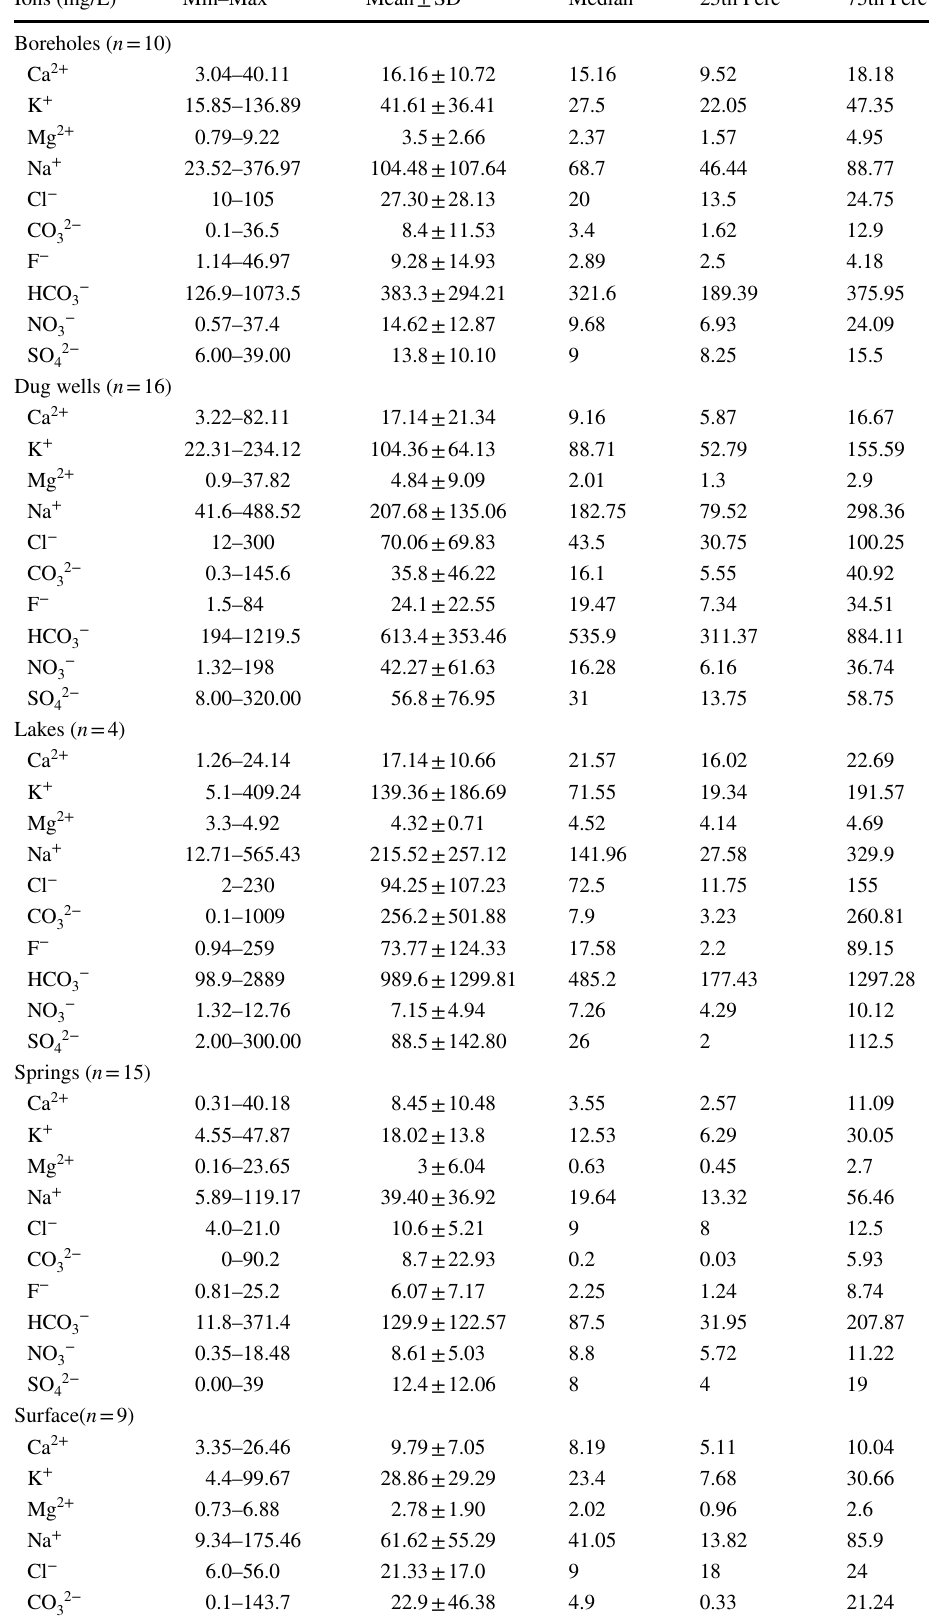
Table 2 Statistical summary of the major